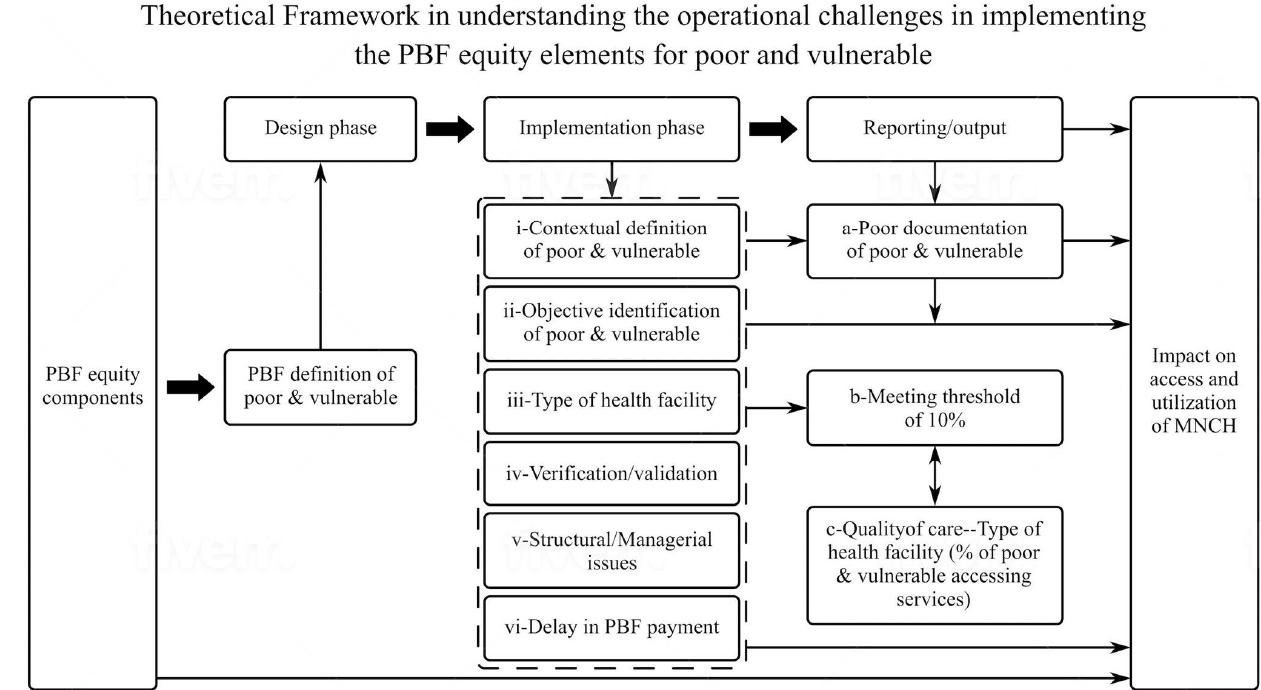
Figure 1. Theoretical framework in understanding the operational challenges in implementing PBF equity elements for PAV for maternal health. Table 3. Themes generated from the data.